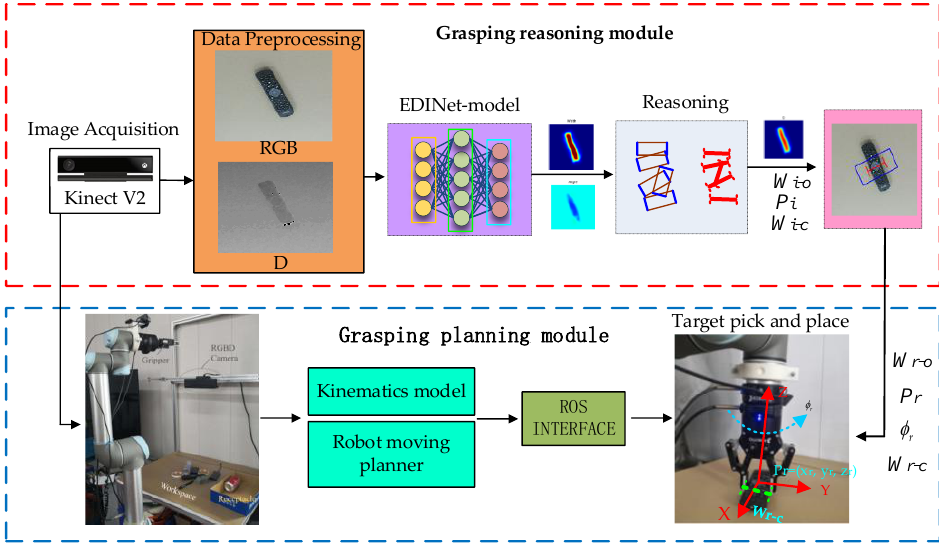
Figure 2. The overview of the robot grasping system.